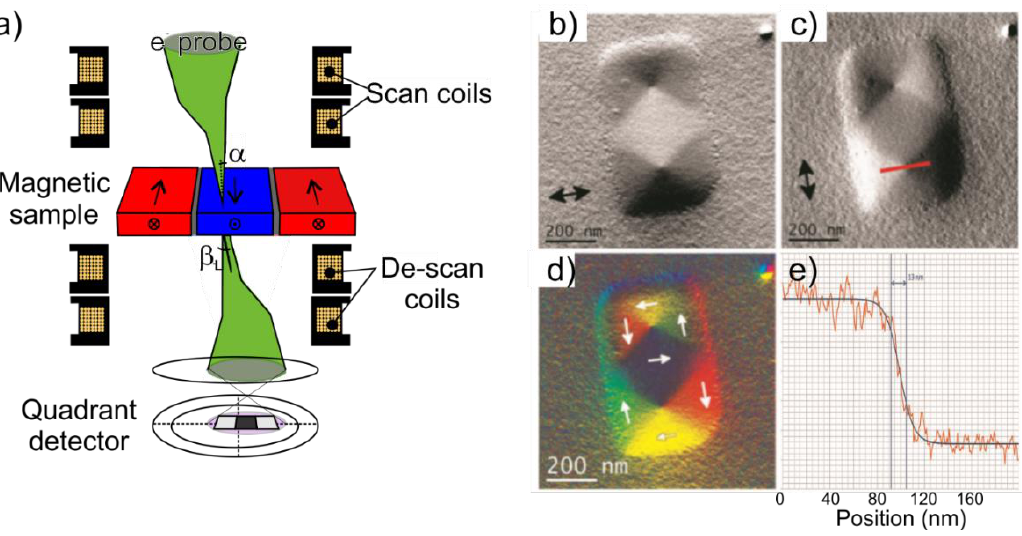
Figure 12. ( a ) scheme of the differential phase contrast (DPC) technique in L-STEM; ( b , c ) L-STEM images of a Fe nanostructure (from Fe exacarbonyl by EBID) with its in-plane components; ( d ) DPC color image (representation of the color wheel shown in the top-right inset) and ( e ) the profile of the line selected in ( c ) showing the induction profile, as measured from the deflection angle at the vortex core. β L is Lorentz deflection angle. Panels b–e are reprinted with permission from [153], copyright by Elsevier, 2015.